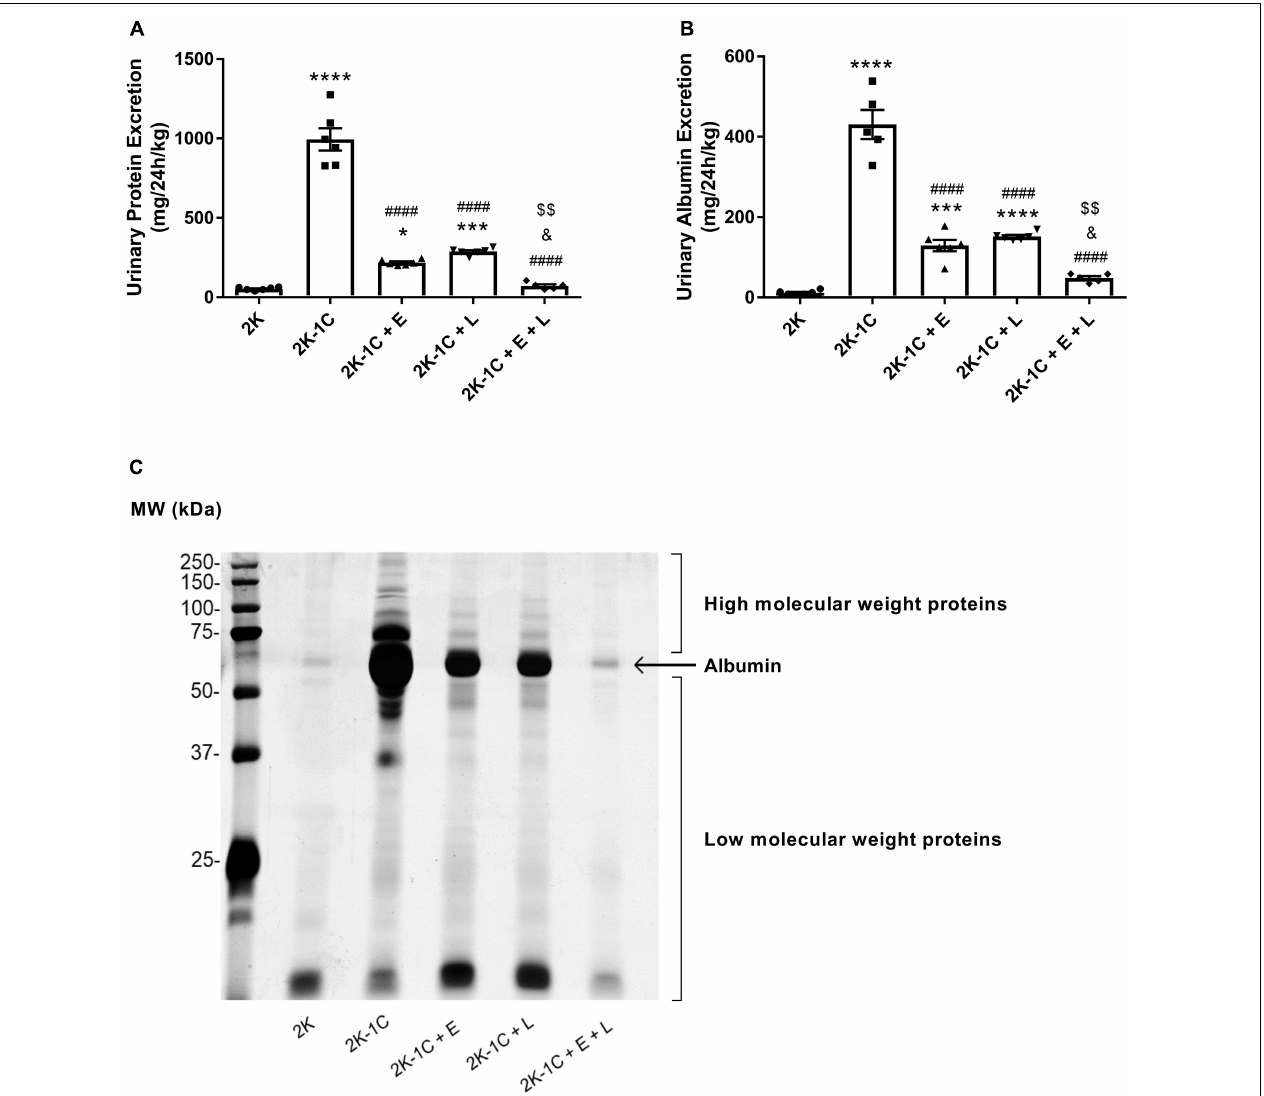
FIGURE 2 | Dual RAS blockade, but not losartan or enalapril alone, normalizes proteinuria and albuminuria in renovascular hypertensive rats. Two-kidney one-clip (2K-1C) renovascular-hypertensive rats treated with enalapril (2K-1C + E, 20 mg/kg/day), losartan (2K-1C + L, 30 mg/kg/day), enalapril plus losartan (2K-1C + E + L, 30 and 20 mg/kg/day, respectively), or vehicle (2K-1C) and vehicle-treated control rats (2K) were placed into metabolic cages for 24-h urine collection. (A) Urinary protein excretion was measured using a commercially available kit based on the pyrogallol red-molybdate method. (B) Urinary albumin concentration was determined by ELISA. The values represent individual measurements and the means ± SEM. * P < 0.05,*** P < 0.001, and **** P < 0.0001 vs. 2K; #### P < 0.0001 vs. 2K-1C; & P < 0.05 vs. 2K-1C + E; $$ P < 0.01 vs. 2K-1C + L. (C) Profile of urine proteins excreted by the five groups of rats. The 24-h urine samples (volume equivalent to 5.0 µ g of creatinine) were subjected to 10% SDS-PAGE. Following electrophoresis, the gels were silver stained. The urinary excretion of proteins of a size smaller than albumin (low molecular weight proteins) and higher than albumin (high molecular weight proteins) is indicated in the representative